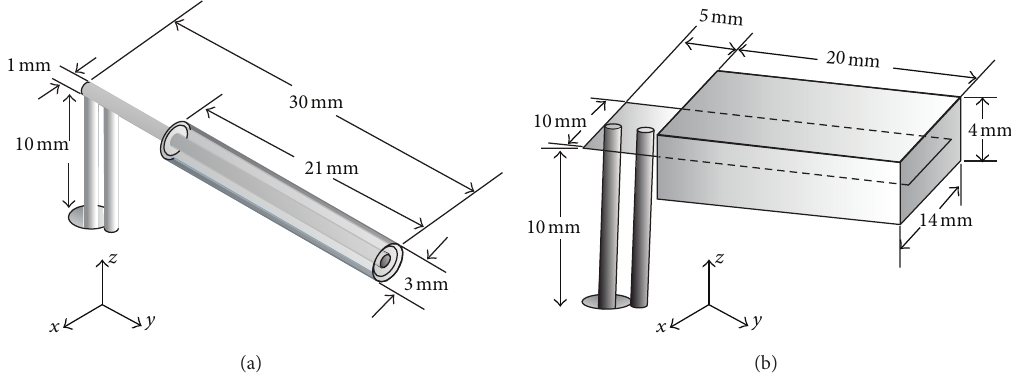
Figure 7: Proposed reduced antennas and (a) IFA, (b) PIFA.